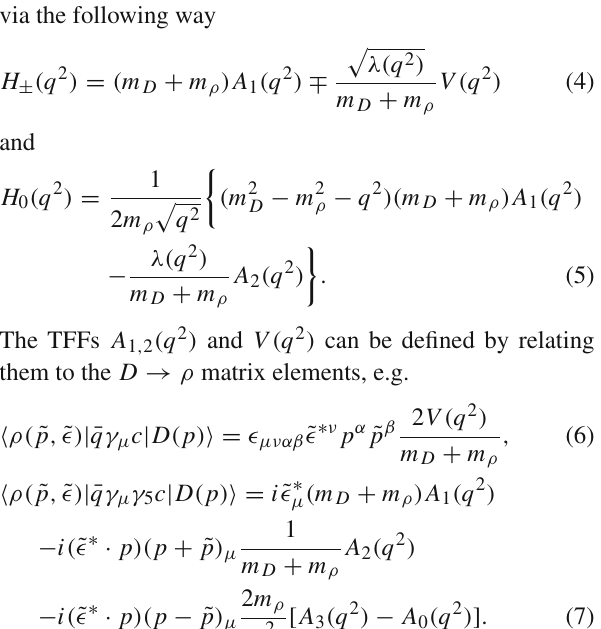
where (cid:5) T = (cid:5) + + (cid:5) − and (cid:5) L = (cid:5) 0 . Here we have adopted the helicity basis to express the decay width. In the helicity basis, the TFF H a ( q 2 )